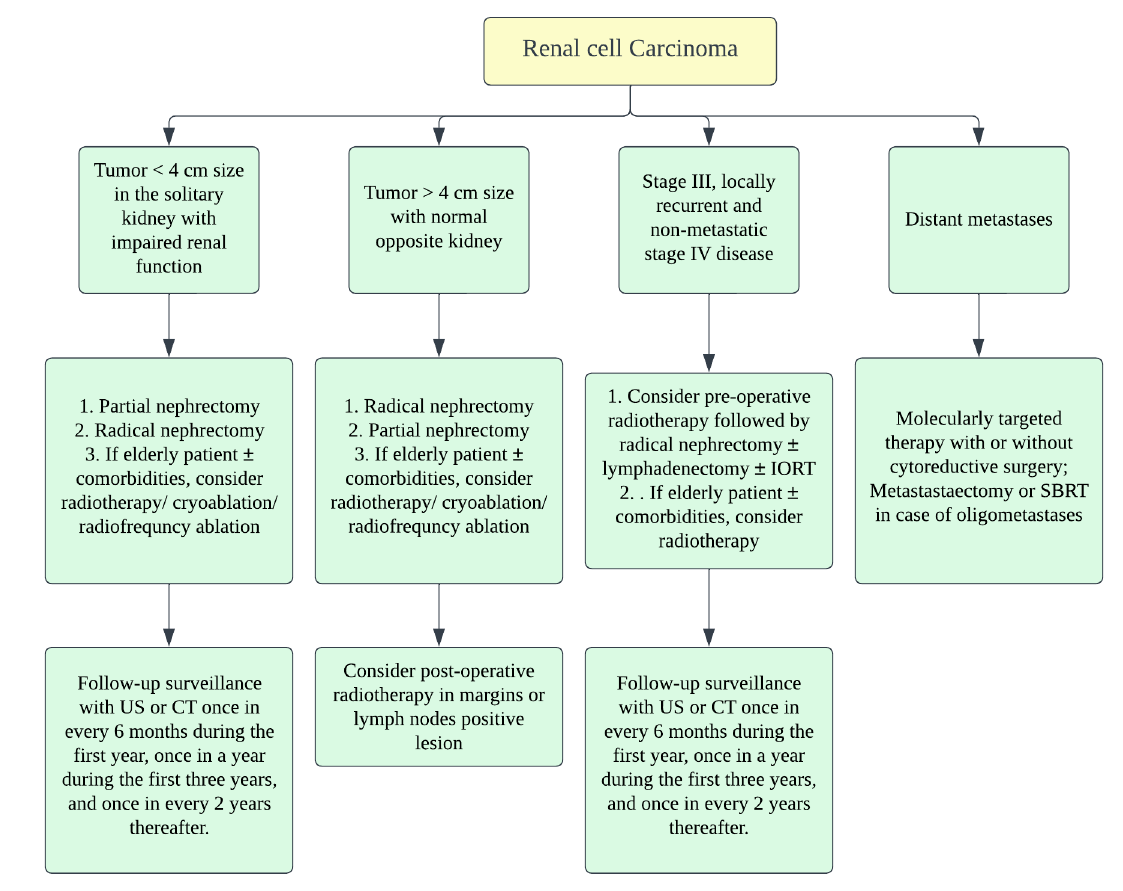
Figure 6. Treatment algorithm of renal malignancies.